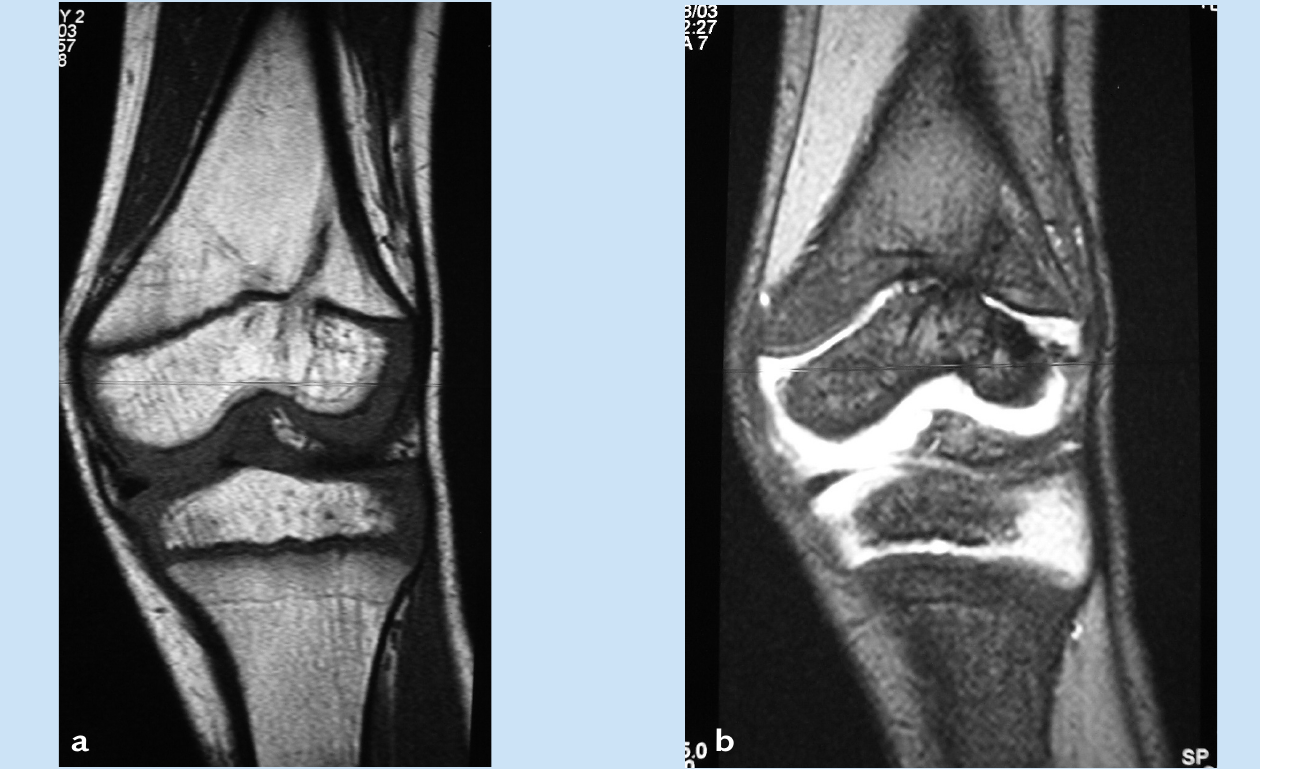
Fig. 1. Post-traumatic physeal bar due to a Salter Harris IV fracture – T1 weighted (a) and gradient echo (b) sequences demonstrate a continuous bar as well as the fracture line in both the metaphysis and epiphysis. The distal femur is a common site for post-traumatic physeal bars. The physis is regular, however, and the epiphysis is not significantly